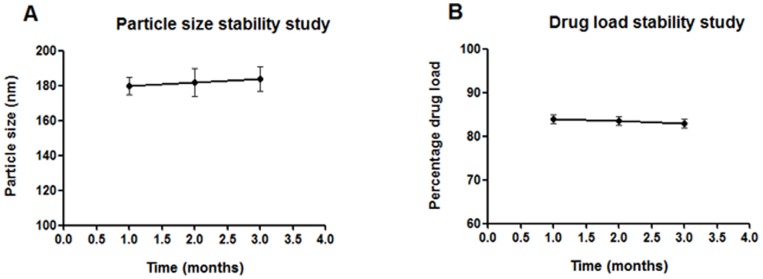
Stability study of andrographolide nanoparticles.(A), Particle size stability study. (B), Drug load stability study. Stability data for AG nanoparticles designed with TPGS stored under refrigeration (4±0.5°C) for a period of three months. During this period AGnps were stable. However, minute AG leaching (nearly 1%) from the nanoparticle preparation was observed after three months.